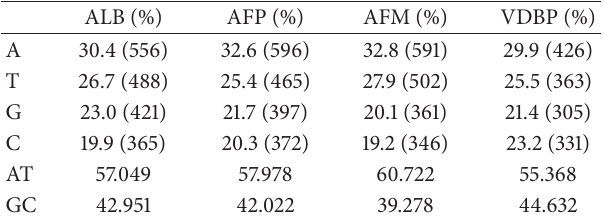
Table 2: Nucleotide distribution of human albumin superfamily